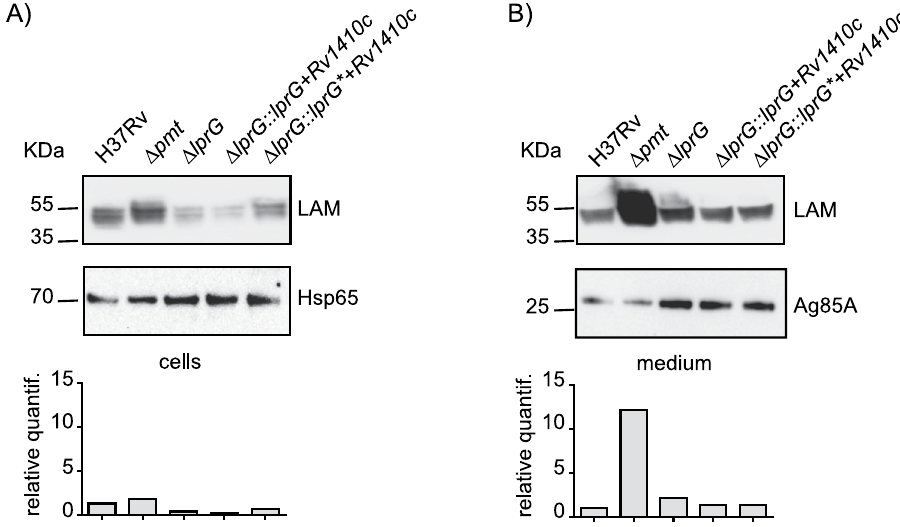
Figure 5. Impact of protein O -mannosylation on LAM production. Crude extracts obtained from the culture medium ( B ) or bacterial cells ( A ) were separated by SDS-PAGE, transferred onto membranes, and analyzed using antibodies raised against LAM and either hsp65 (for cellular extracts) or Ag85A (for medium supernatants). The signal intensity for LAM was quantified and plotted in the graph below the western blot image. This blot is representative of two independent